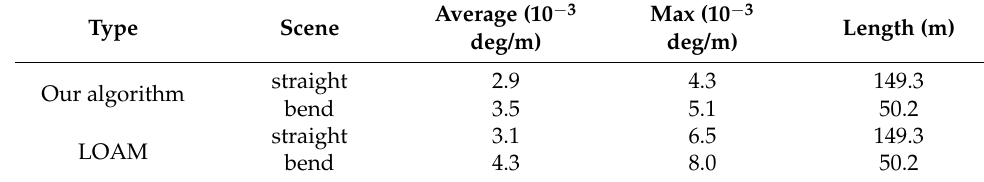
Table 2. Relative attitude error.